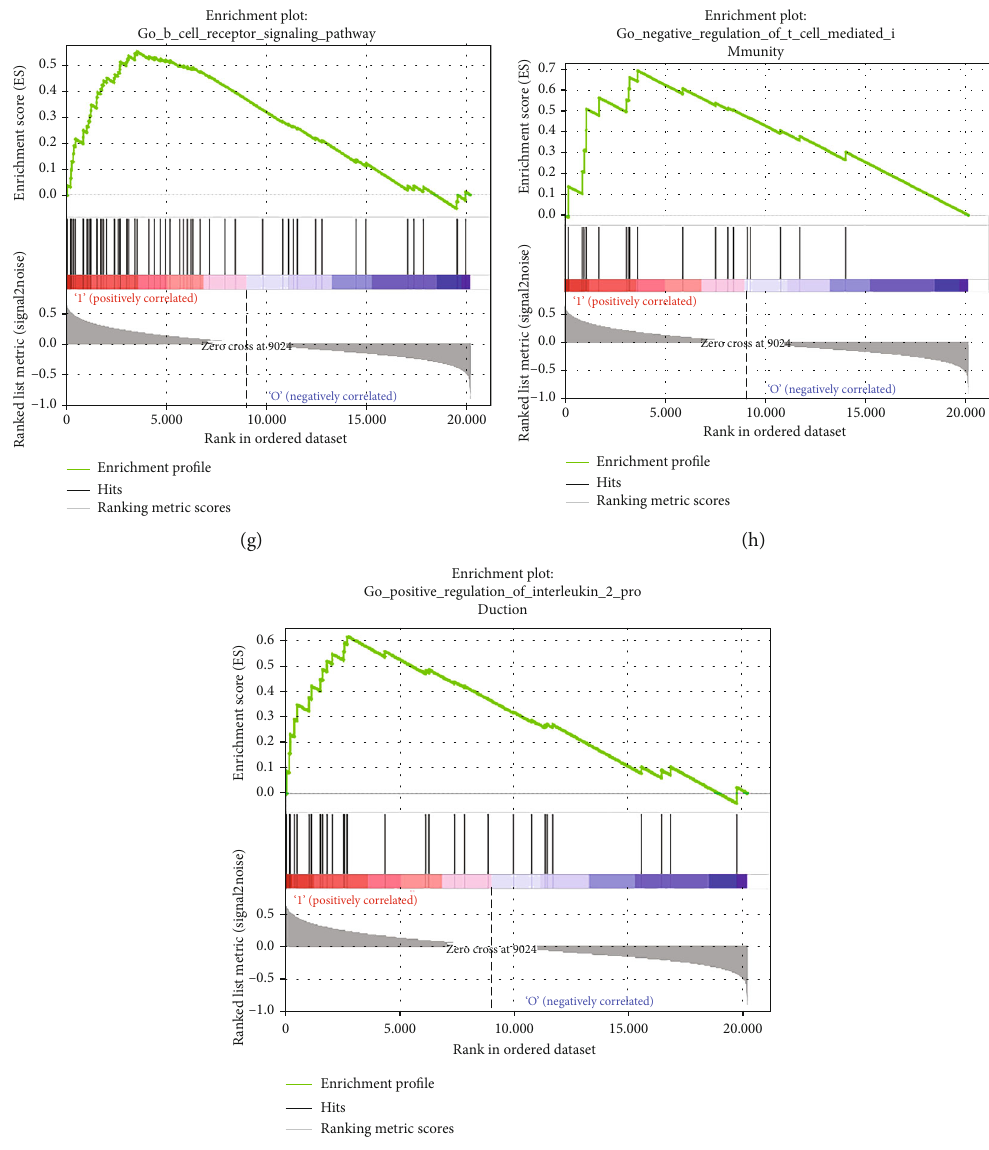
Figure 3: Upregulated gene expression was associated with an immunologic process and was validated by GSEA of GO gene sets analysis of high expression of SHMT2 in GSE21933, GSE31210, and GSE116959. (a) Leukocyte activation involved in in fl ammatory response, (b) macrophage activation, (c) response to interleukin 6, (d) adaptive immune response, (e) alpha beta T cell activation, (f) alpha beta T cell di ff erentiation, (g) B cell receptor signaling pathway, (h) negative regulation of T cell mediated immunity, and (i) positive regulation of interleukin 2